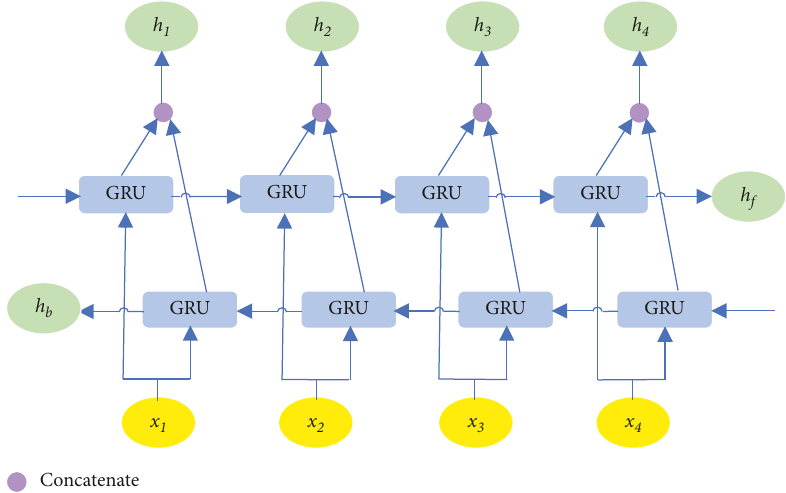
Figure 2: The structure of bidirectional GRU